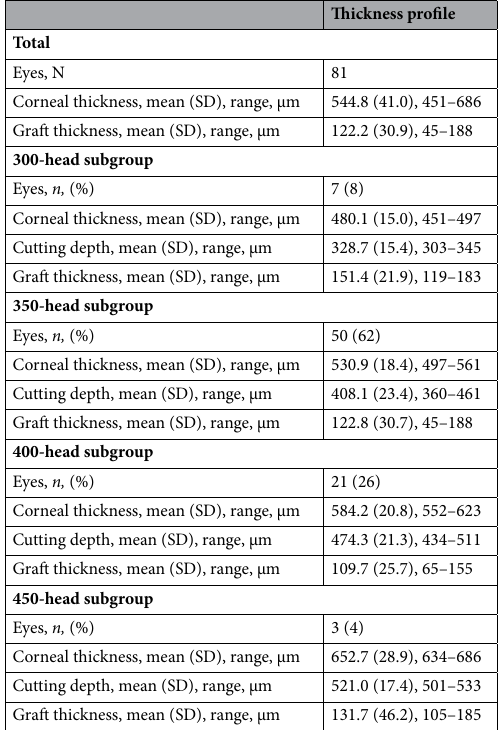
Table 2. Thickness profile by the microkeratome head size. SD, standard deviation.